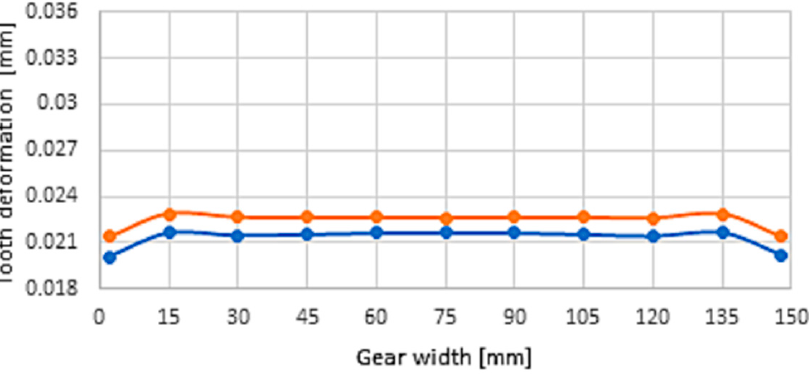
Figure 14. Deformation along the width of the tooth for model B4.